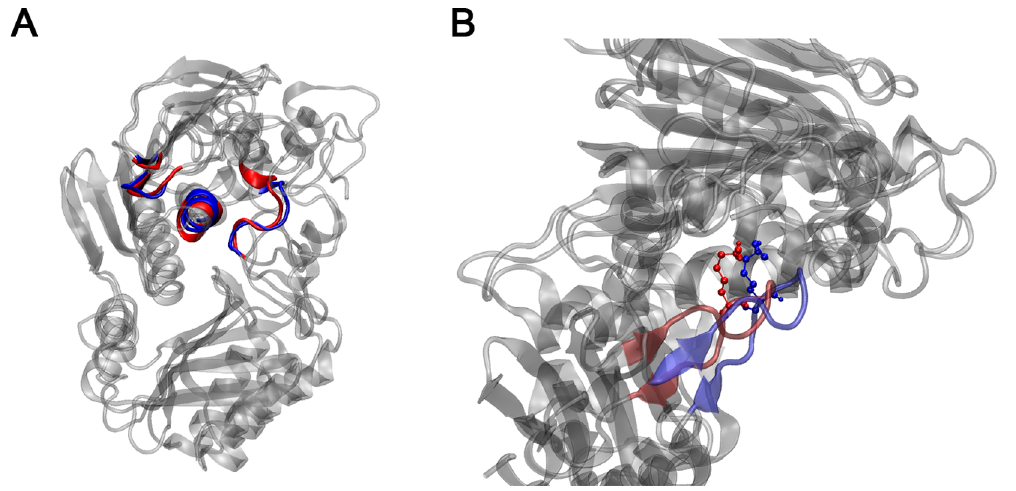
Figure 2. Cluster analysis of MutL PaNTD and EcNTD. A) The central structure of the main cluster of ATP-bound PaNTD and EcNTD were compared. The corresponding ATP binding motives (I–IV) are colored (PaNTD in red; EcNTD in blue). B) Relative position in the superimposed structures mentioned of the conserved residue lysine of motif V (K307 in EcNTD, blue and 310 in PaNTD, red).